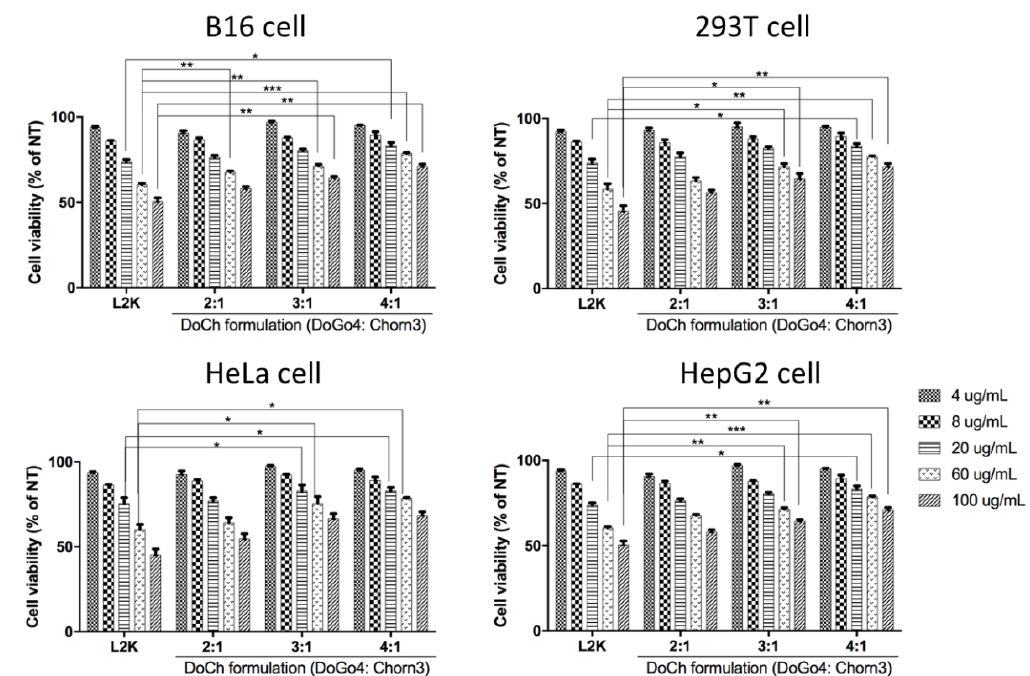
Figure 2. Measurement of cytotoxicity of DoCh formulations. Cells were treated with L2K or DoCh formulations at indicated concentrations for 24 h. Cell viability was measured by MTT assay. * p